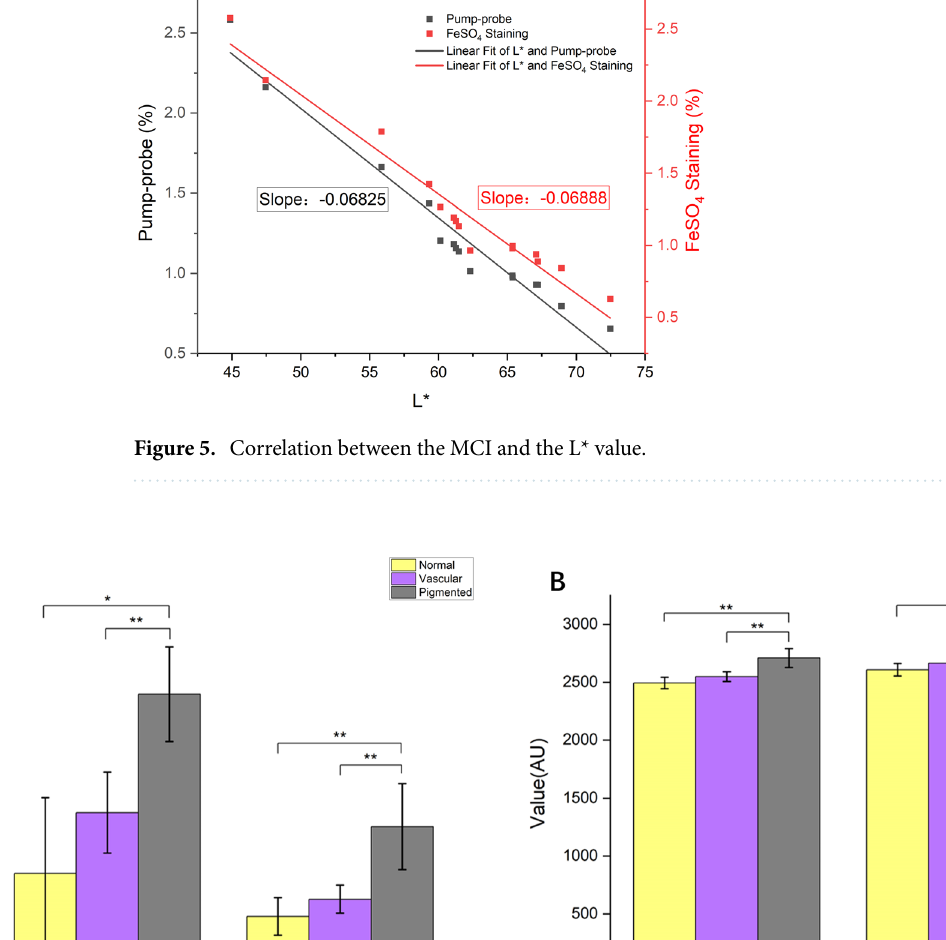
(Fig. 4). It revealed the same precise details in the distribution of melanin granules as the bright-field images of a similar field in Fig. 4C. At zero delays between the pump and the probe pulse, the base cell layer separated the epidermal layer and the dermis, and the basal layer was easily identified as thick-bright melanin dots, with a typical papillary protrusion (Fig. 4A). When the interpulse delay was increased to 300 fs to remove the contribu- tion of any coherent or instantaneous effects, the stratum corneum is exposed, which could be represented as a bright line due to the strong signal of the tissue edge. The dermis could also show scattered melanin granules, which demonstrated a positive signal from real excited states generated by the pump pulse (Fig. 4B, white box). Meanwhile, the pure melanin solution showed a uniform gray bright signal in the pump-probe imaging (Fig. 4D, yellow box). By analyzing the spectra of the target signal points in pump-probe images of the label-free sections (Fig. 4A,B, white box) and standard substance (pure melanin solution) (Fig. 4D, yellow box), the signal curve behavior of the label-free sections is almost consistent with that of the standard substance (Fig. 4E). Then, we calculated the area fractions of melanin granules in pump-probe images and FeSO 4 -stained images, which were named as MCI (Fig. 5). The MCIs of two sorts of images were negatively correlated with the L* value of every patient’s photograph under standard conditions, while the linear fit of L* and MCI in pump-probe images showed nearly the same slope as that in FeSO 4 staining (Fig. 5). In addition, the ICC of MCIs in the two imaging methods was 0.997 (P < 0.001). Quantization comparison of melanin in the skin with dark circles and normal skin. Randomly and respectively, five regions of the epidermal basal layer and five dermal regions were selected to calculate the MCI-1 and MCI-2. In the comparison of the pigmented group with the vascular group and normal group, MCI-1, and MCI-2 values were significantly elevated and different (Fig. 6A). However, the MCI-1 and MCI-2 of the vascular group were also higher than those of the normal group, but the differences were not significant